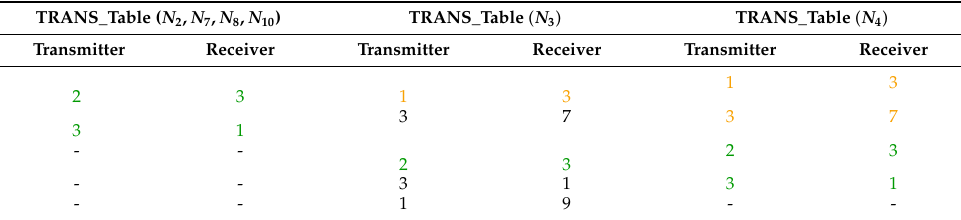
Table 5. Transmission table of N 2 and its neighbors after the REQ message transmission of N 2 .